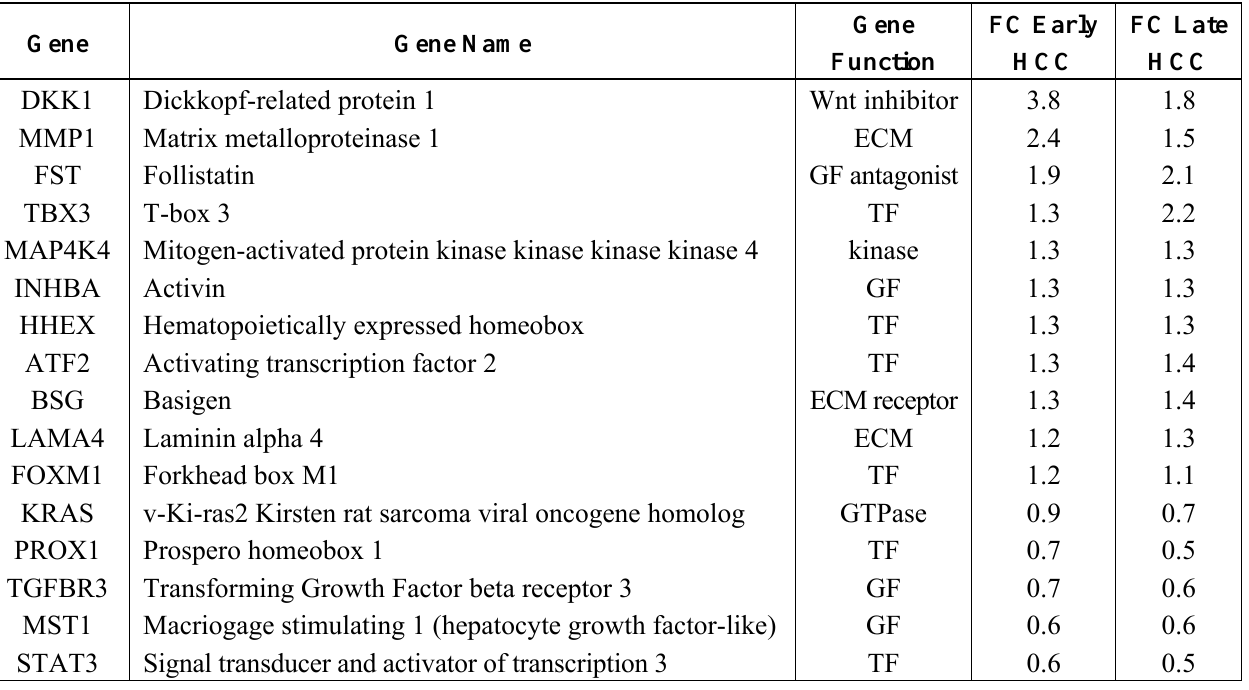
Table 2. Genes uniquely changed in HCC ( α <